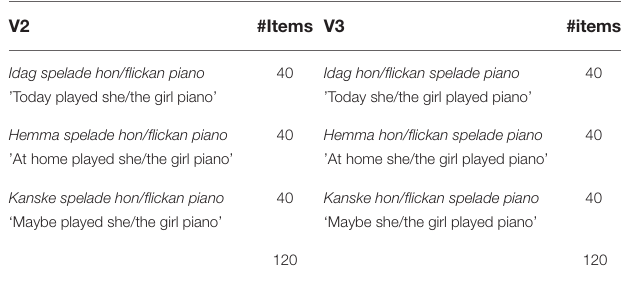
TABLE 3 | Example and number of items of the experimental sentences in the AJT/ERP